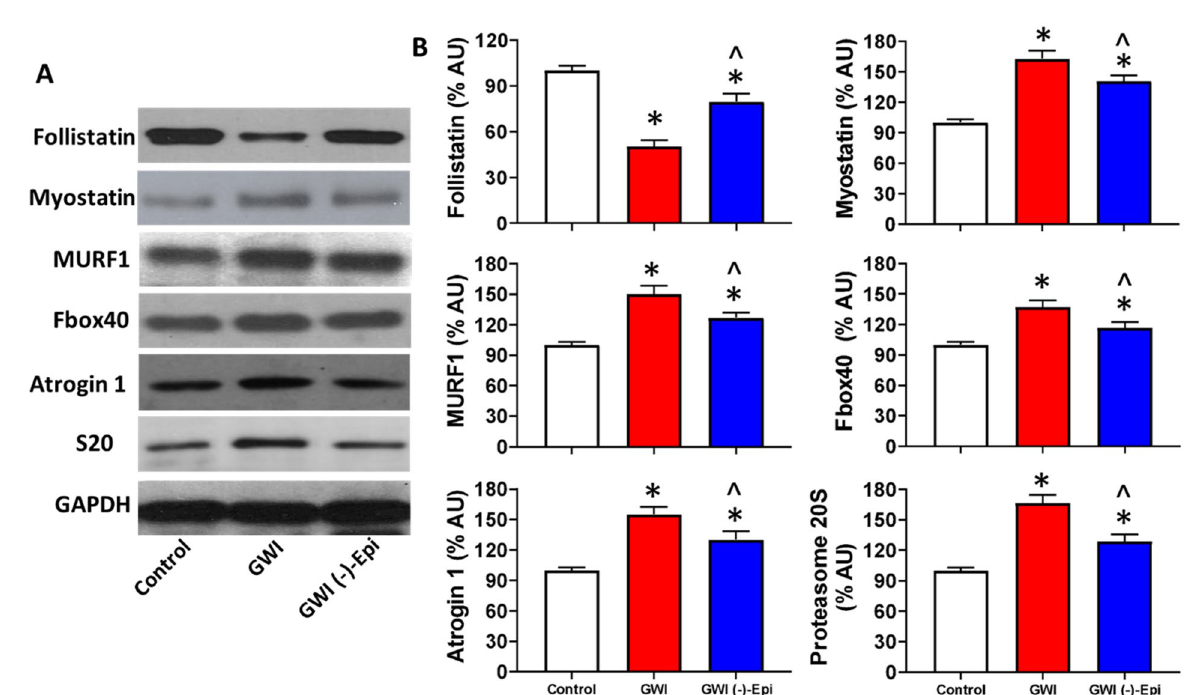
Figure 7. Beneficial effects of (−)-epicatechin (Epi) on modulators of GWI muscle mass. (A) Illustrates a representative image of Western blots and ( B ) reports on relative changes in protein levels of